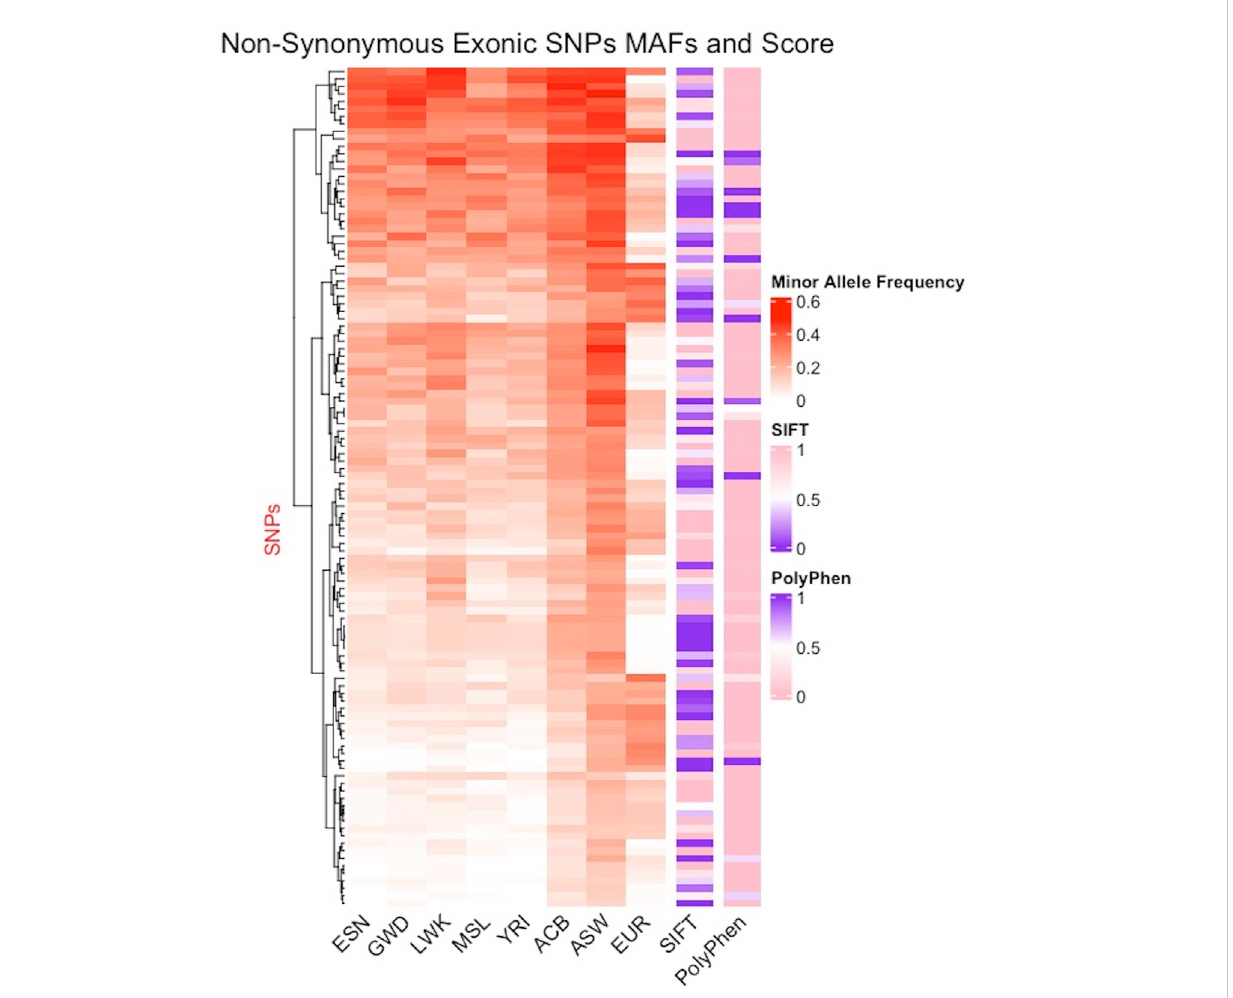
FIGURE 5 Distribution of minor allele frequencies in African AIMs. AIMs found in the coding regions of the genome and carrying non-synonymous mutations are juxtaposed next to the SIFT and Polyphen2 scores for each SNPs. Of the 338 exonic SNPs, 164 are non-synonymous mutations, 149 of which were scored by thetools.ExcludingtheX-linkedSNPsandmultiallelicsites,only112SNPswerenon-synonymousandareplottedhere.ThecolorgradientfortheMAFranges fromwhite(0)tored(0.6);thegradientforSIFTrangefrompurple(0,damaging)topink(1,benign),whilethegradientforPolyphen2rangesfrompink(0, benign) to purple (1,